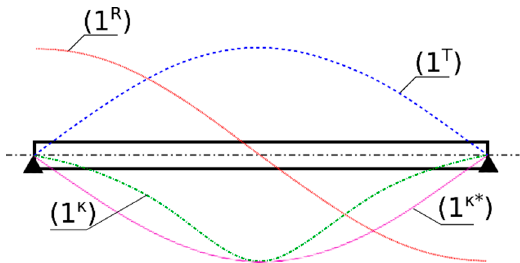
Figure 1. Simply supported Euler–Bernoulli beam and its (1 T ) first transversal natural mode, (1 R ) first rotational natural mode (slope of the first transversal mode), (1 κ ) first curvature natural mode, and (1 κ *) approximation of the first curvature natural mode as a second derivative of the first transversal mode.